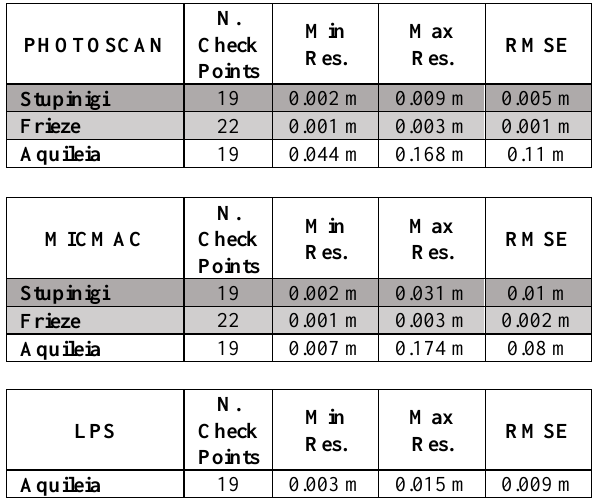
Table 4. Accuracy assessment of the achieved